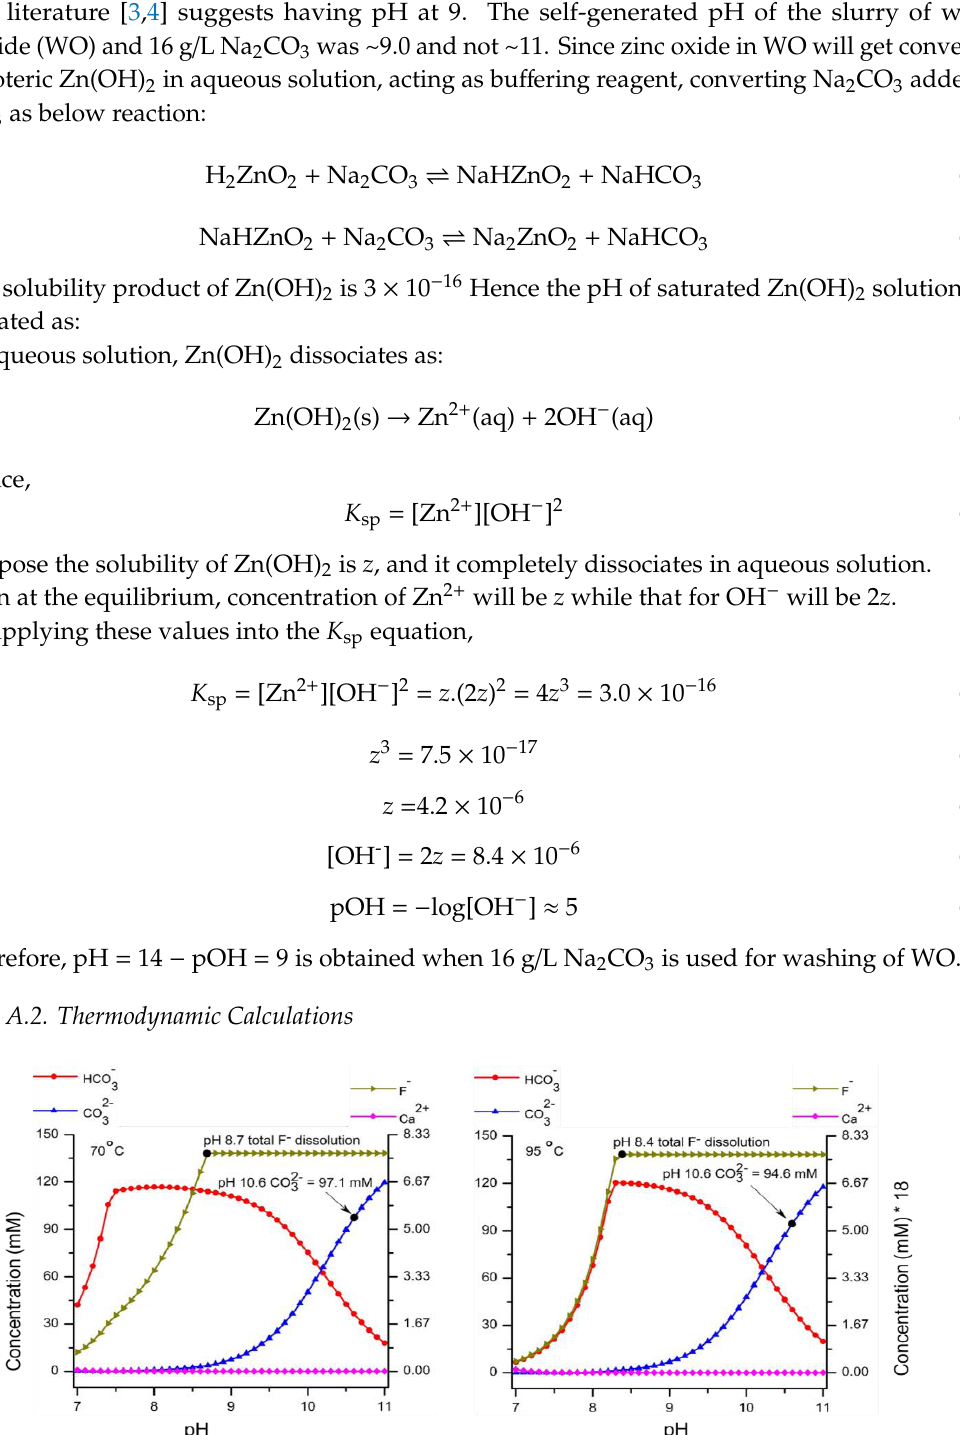
Figure A2. Thermodynamic calculation with 150 mM NaHCO 3 and 300 mg/L CaF 2 from pH range 7– 11 and temperature (70 and 95 °C).